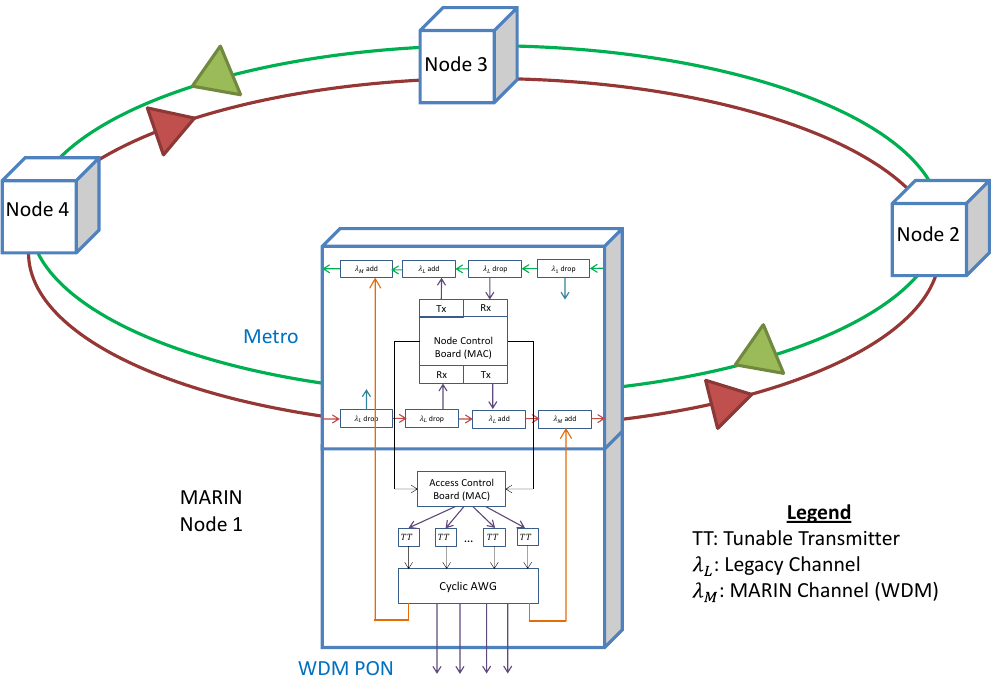
Figure 12. The MARIN architecture [82].